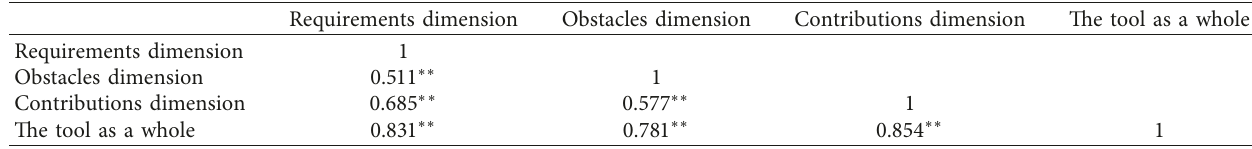
Table 3: Correlation coefficients between dimensions and overall score.